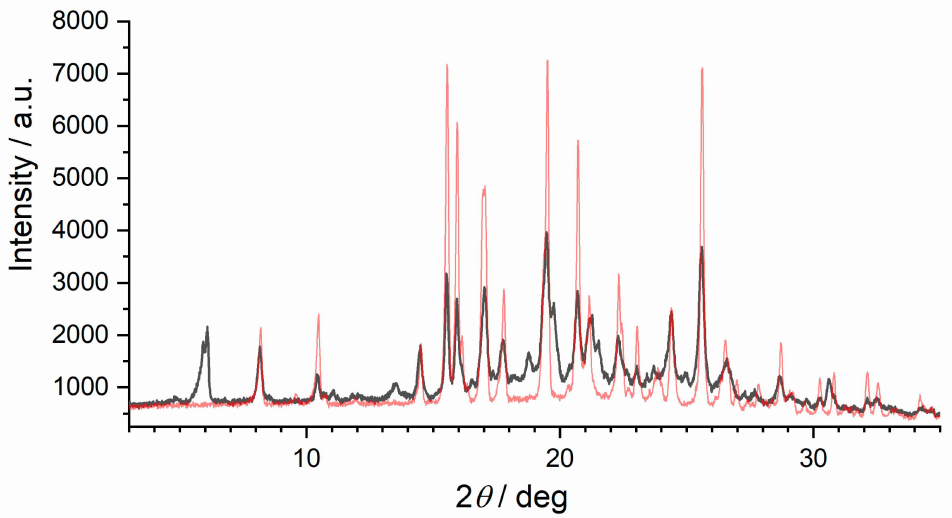
Figure 5. Powder X-ray patterns showing the appearance of the new polymorph form IV: comparison of form I (red) and the powder pattern after heating form I in a capillary to 110 ◦ C followed by cooling to − 50 ◦ C (black).